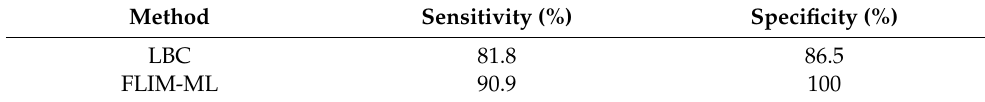
Figure 6. Confusion matrixes of the two methods: ( a ) LBC test; ( b ) FLIM-ML method. Table 4. Sensitivity and specificity of the LBC test and FLIM-ML method.